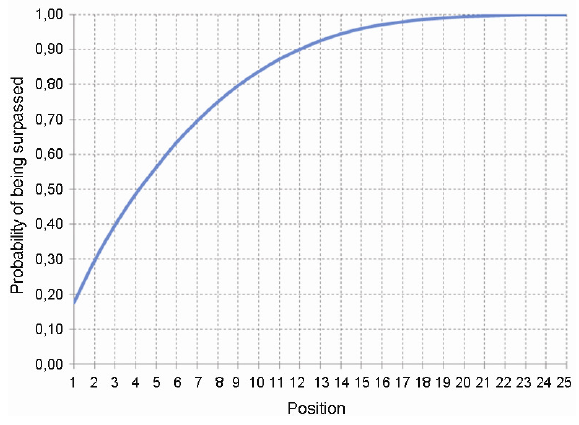
Fig. 3. Position performance for a single